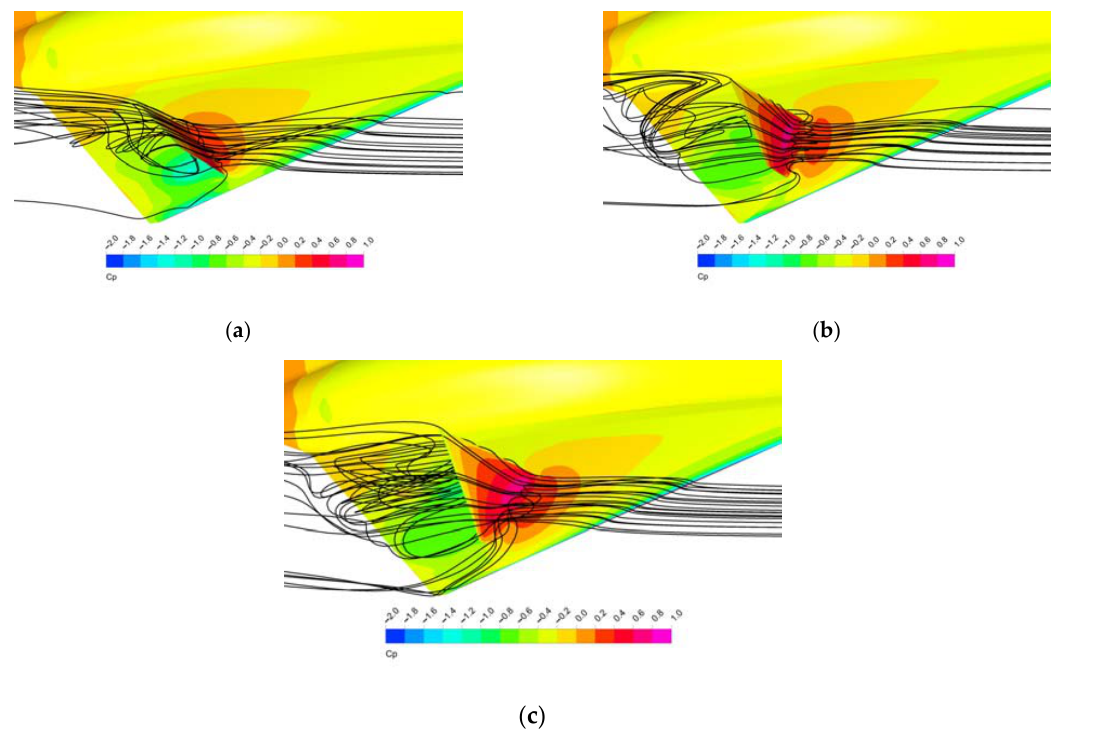
0.12 Table 5. Comparison between the elevon and SSDs at α = 6°. Case